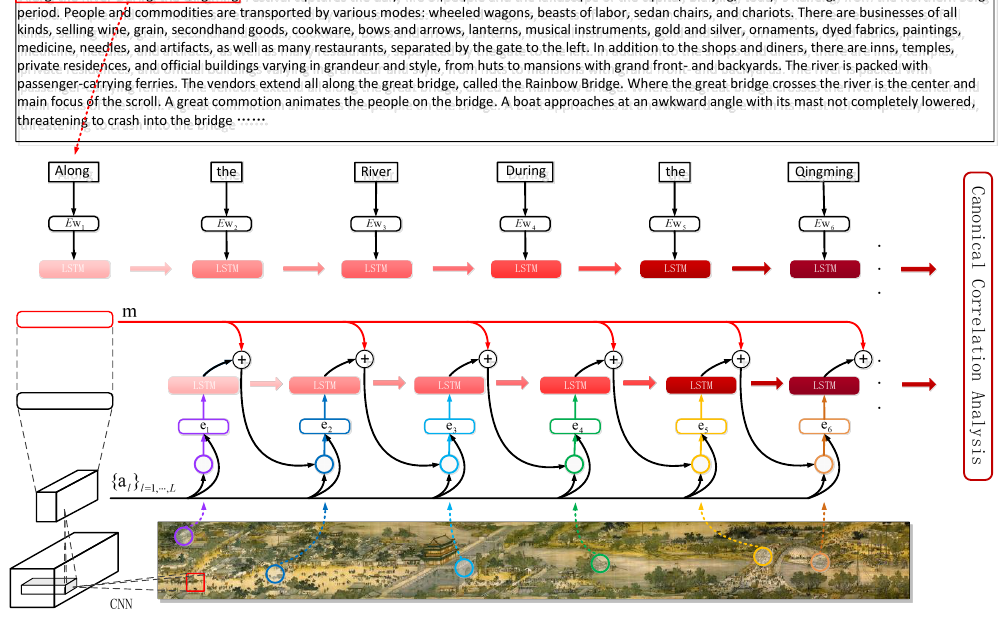
Figure 1. The proposed recurrent canonical correlation analysis